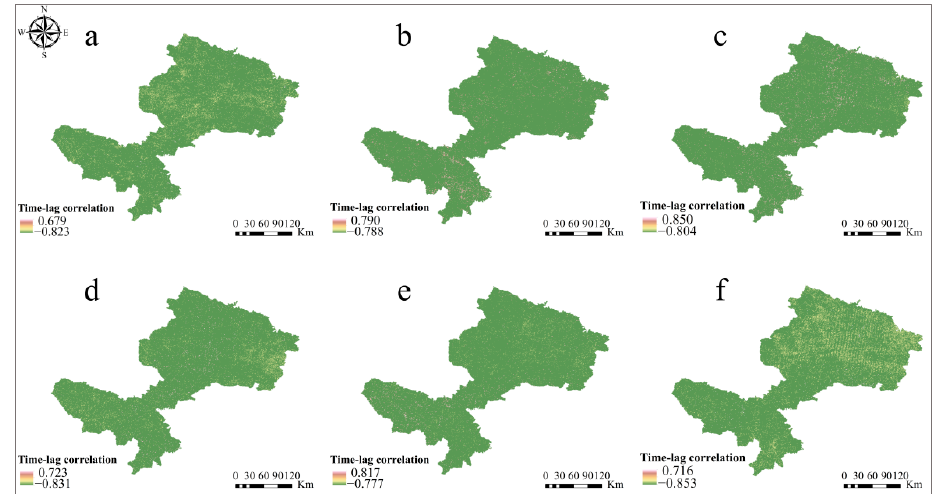
Figure 6. Spatial distribution of the time-lag correlation between pH and NPP in summer during 2000–2021: ( a ) time-lag correlation between pH in June and NPP in July, ( b ) time-lag correlation between pH in June and NPP in August, ( c ) time-lag correlation between pH in July and NPP in August, ( d ) time-lag correlation between pH in July and NPP in June, ( e ) time-lag correlation between pH in August and NPP in June, and ( f ) time-lag correlation between pH in August and NPP in July.